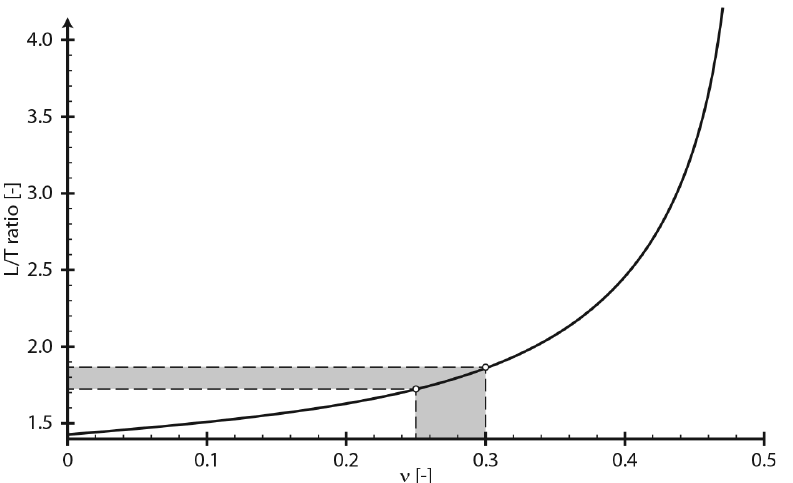
Figure 1. c L /c T as a function of the Poisson’s ratio ν for isotropic continuum. The selected area of values common for structural steels ( ν = 0 . 25 ÷ 0 . 30) provides expected range of c L /c T = 1 . 73 ÷ 1 . 87 [12].